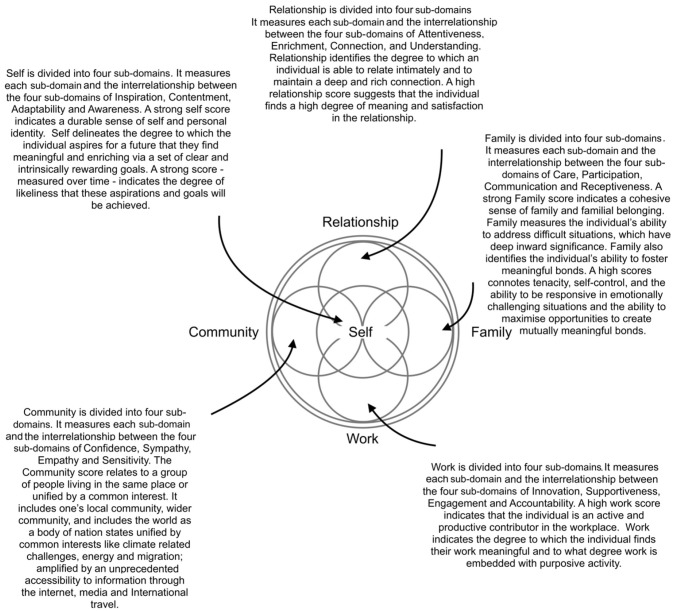
Domain Descriptions.